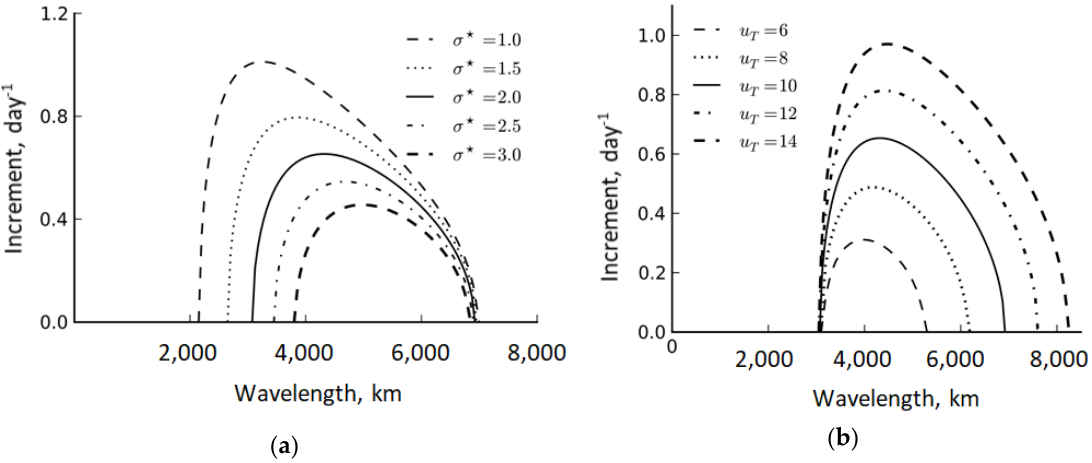
Figure 2. Increments of unstable baroclinic waves for different static stability parameters ( a ) and vertical wind shear ( b ). If we set the discriminant in (8) equal to zero, we can find, first, the marginal stability curve, which will separate unstable atmospheric waves from stable ones (see Figure 3), and second, the shortwave cut-off L β and longwave cut-off L β max . Note that the wavelength of min ≤ L ≤ L β an unstable wave satisfies the condition L β w max . For the “dry” (“moist”) model, min = 3085 km (2333 km) for short waves, and L β = 5945 km (6015 km) for the cut-off is L β max min long waves.